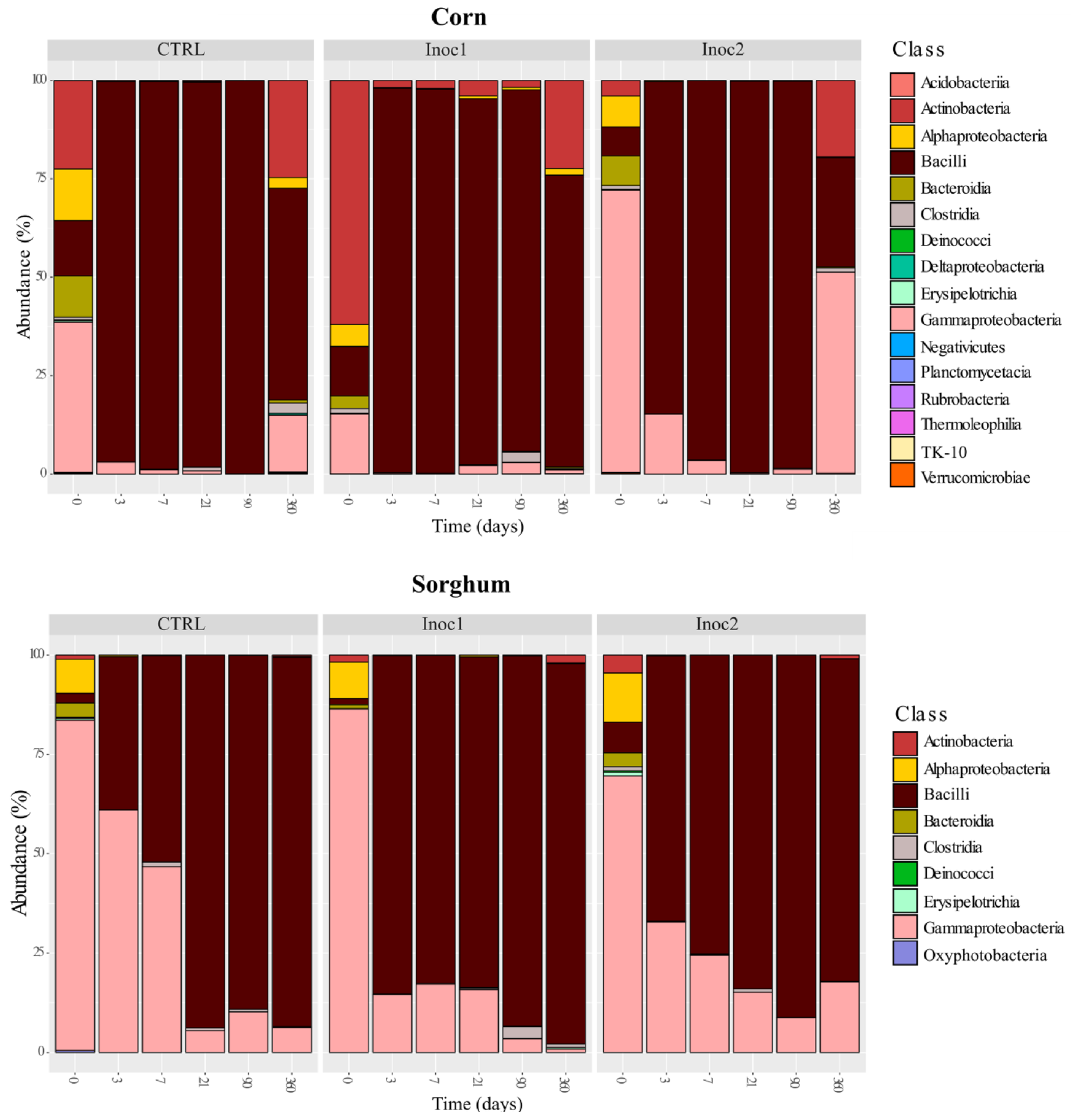
Figure 2. Classes taxonomic profiles of bacterial communities of rehydrated corn and sorghum grain silages after 0, 3, 7, 21, 90 and 360 days of fermentation. CTRL non-inoculated, Inoc1 Lactobacillus plantarum and Propionibacterium acidipropionici , Inoc2 Lactobacillus buchneri